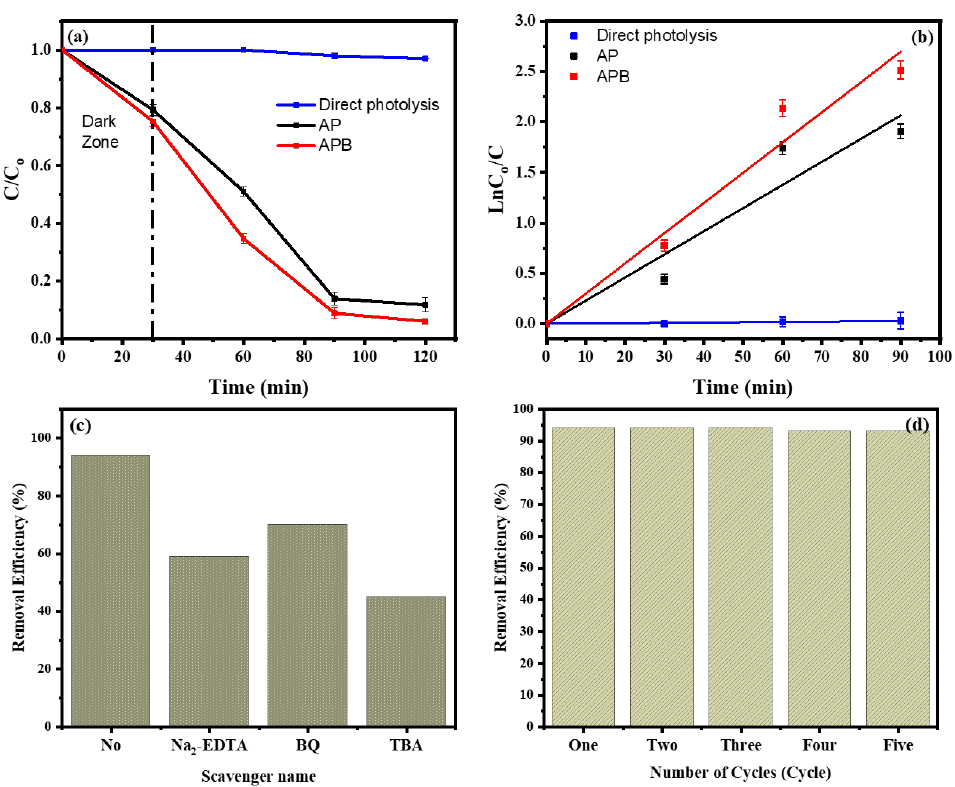
Figure 6. ( a ) The removal curve of MB in the presence of pure Ag 3 PO 4 and BaO@Ag 3 PO 4 nanocom- posite. ( b ) Kinetics of MB removal by pure Ag 3 PO 4 and BaO@Ag 3 PO 4 nanocomposite. ( c ) The influence of different scavengers on the removal efficiency of MB by BaO@Ag 3 PO 4 and ( d ) the removal efficiency of BaO@Ag 3 PO 4 as a catalyst for MB degradation throughout five consecutive cycles of filtration and reuse (after 2 h).